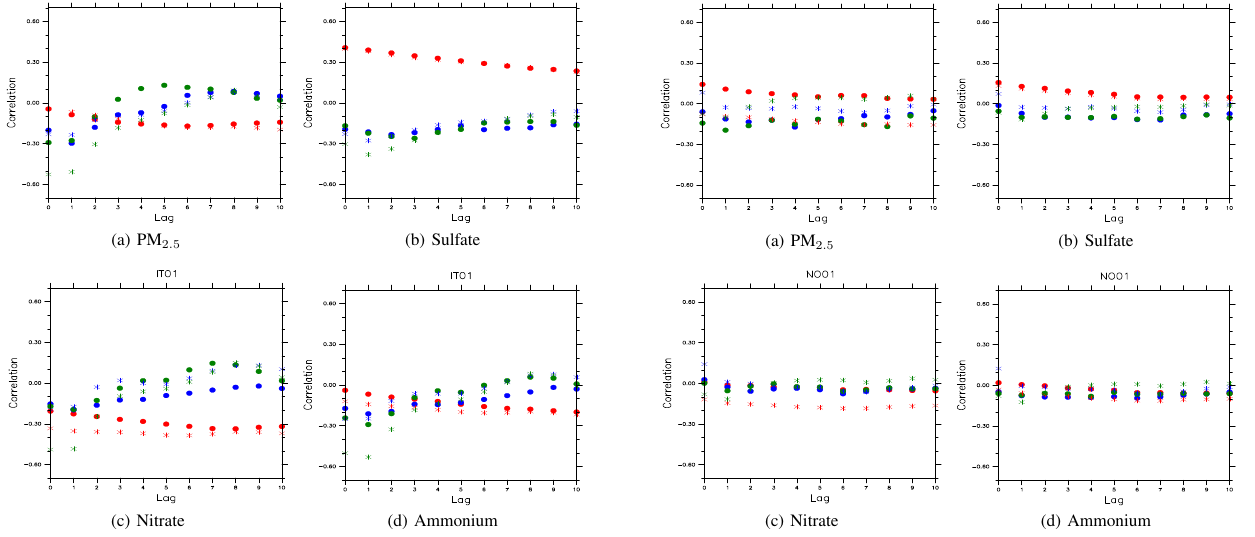
Fig. 9. Correlations between meteorology (temperature in red, pre- Fig. 9 : Correlations between meteorology (temperature in red, precipitation in blue, wind speed cipitation in blue, wind speed in green) on a given day and pollutant in green) on a given day and pollutant concentrations (PM 2 . 5 , sulfate, nitrate and ammonium), concentrations (PM 2 . 5 , sulfate, nitrate, and ammonium), ranging up ranging up to 10 days after at NO01 (2002-2008). Simulated data are represented with a star, to 10 days after at NO01 (2002–2008). Simulated data are repre- while observational data are represented with a dot. 12 sented with a star, while observational data are represented with a